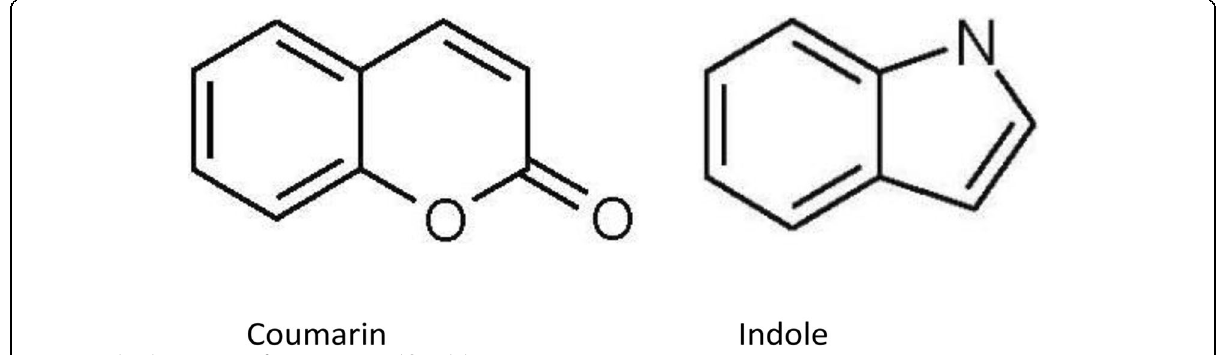
Fig. 18 Molecular structure of a Coumarin and b